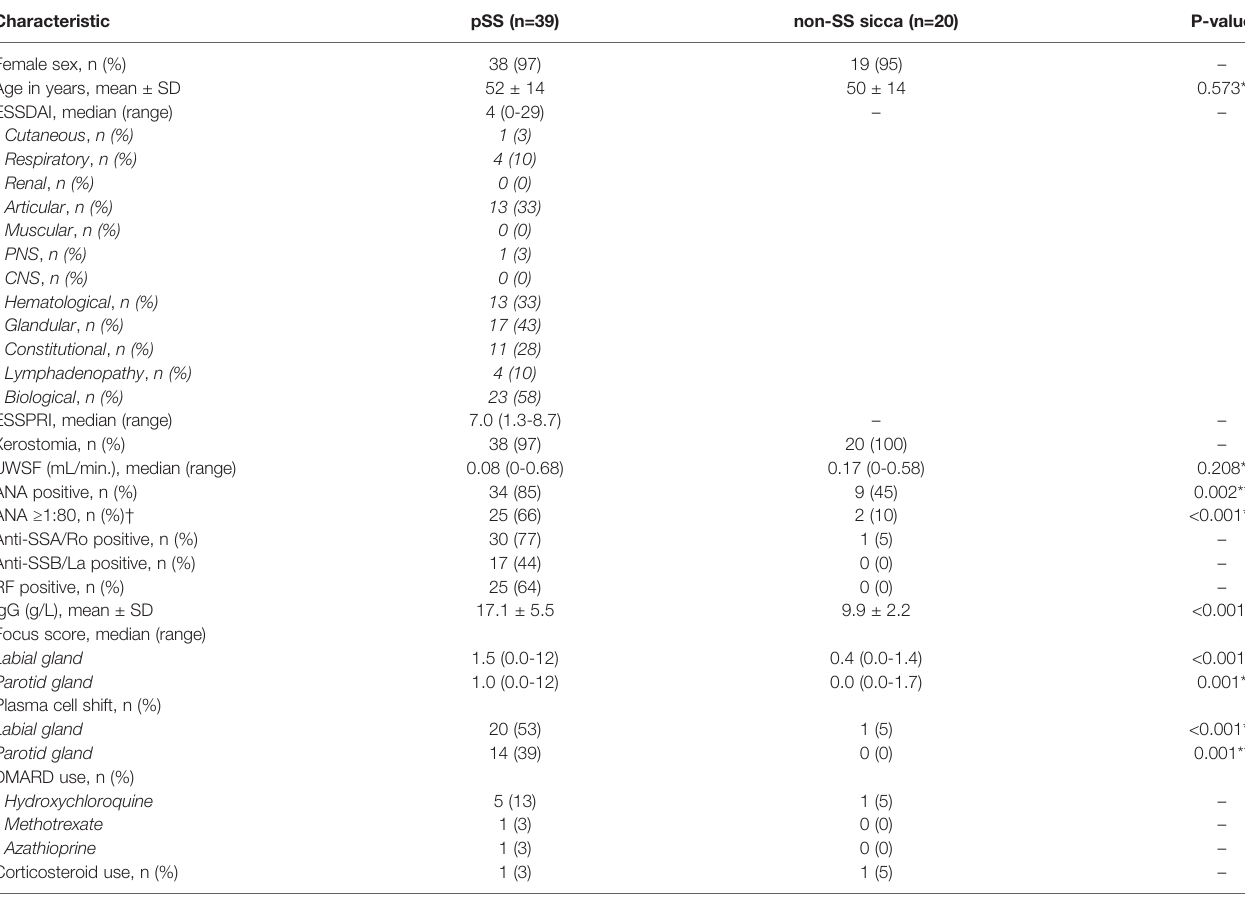
TABLE 1 | Demographic, clinical and histopathological characteristics of the study population.